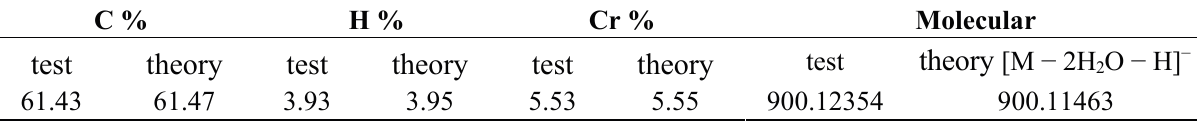
Table 2. Elemental analysis of the complex.